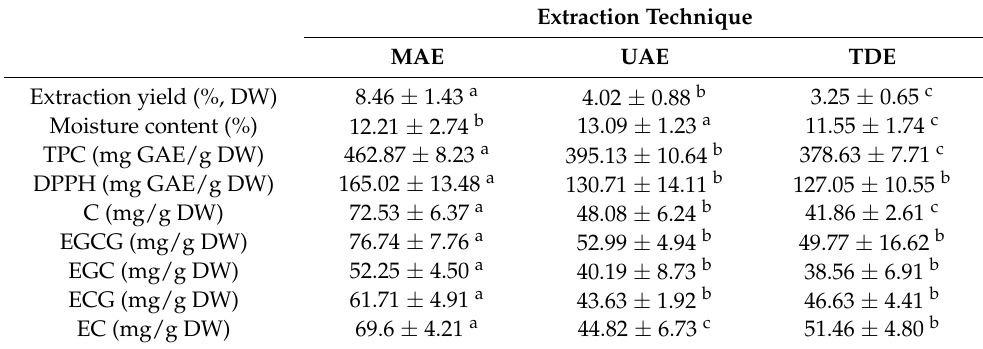
Table 4. Extraction yield, moisture content, antioxidant properties: total phenolic content, DPPH and catechin contents of roasting green tea extracted by different extraction techniques 1